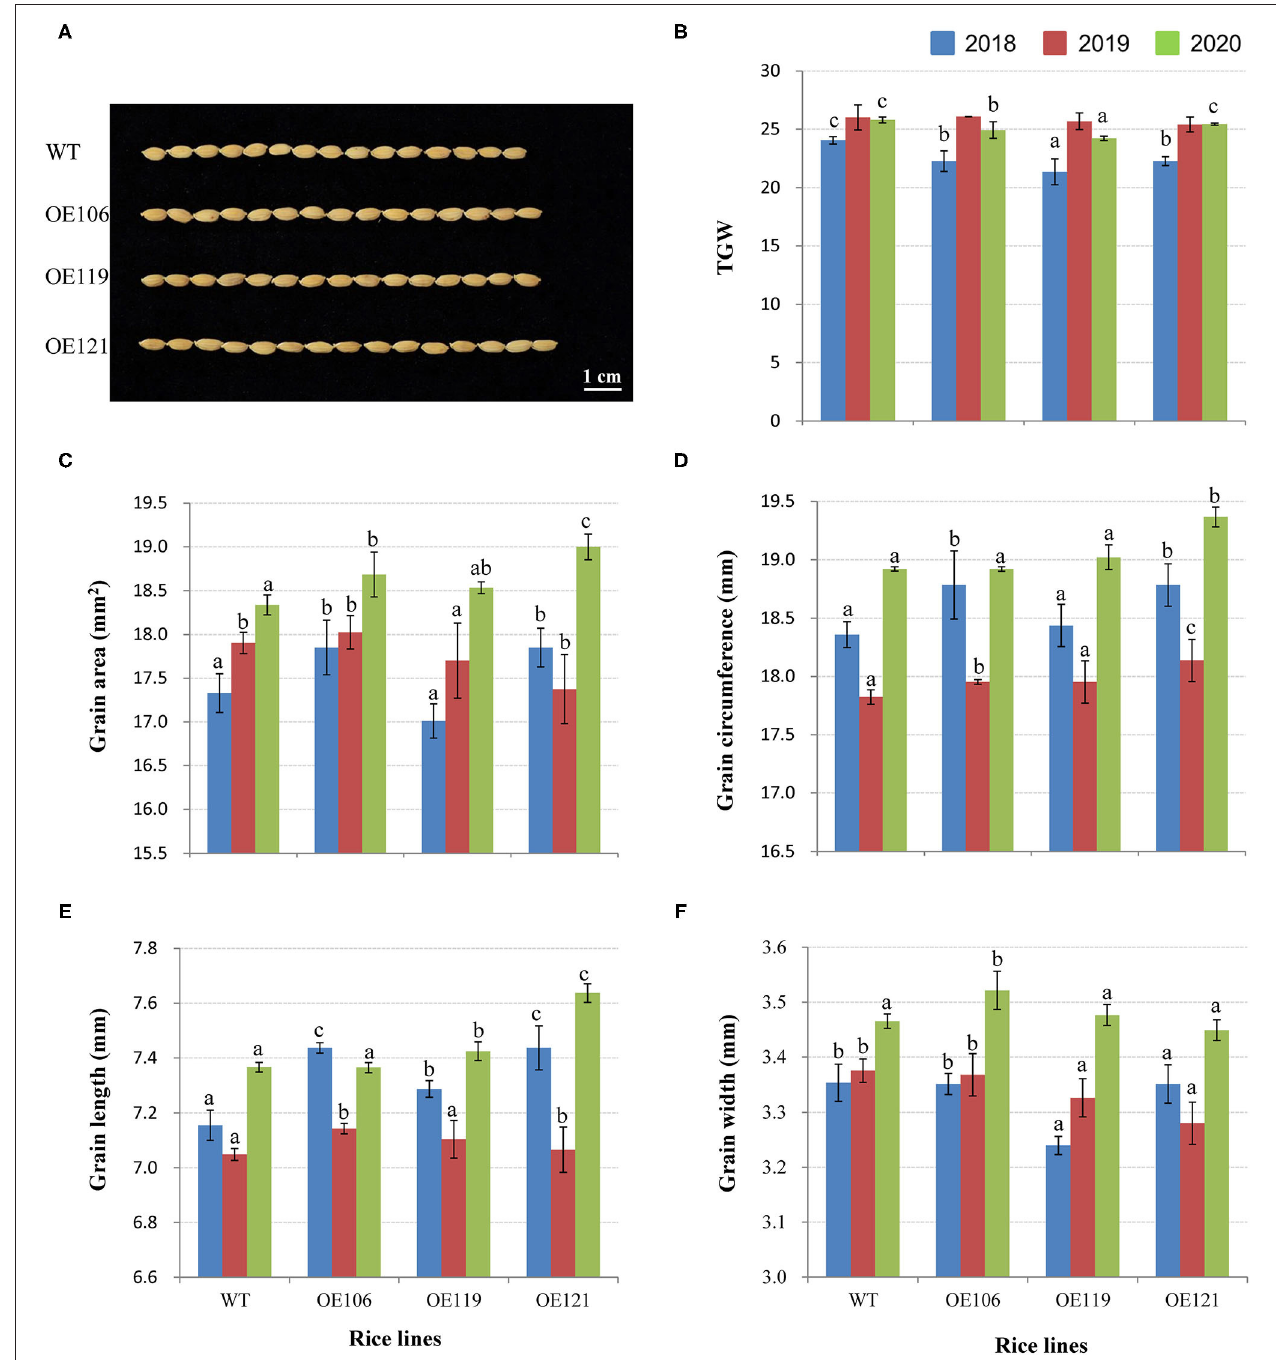
FIGURE 9 | Comparisons of grain traits between the TaWRKY51-overexpressing rice and the WT control. Comparisons of grain length (A,E) , TGW (B) , grain area (C) , grain circumference (D) , and grain width (F) of transgenic rice and the WT control. The images of rice grains were photographed in 2019.